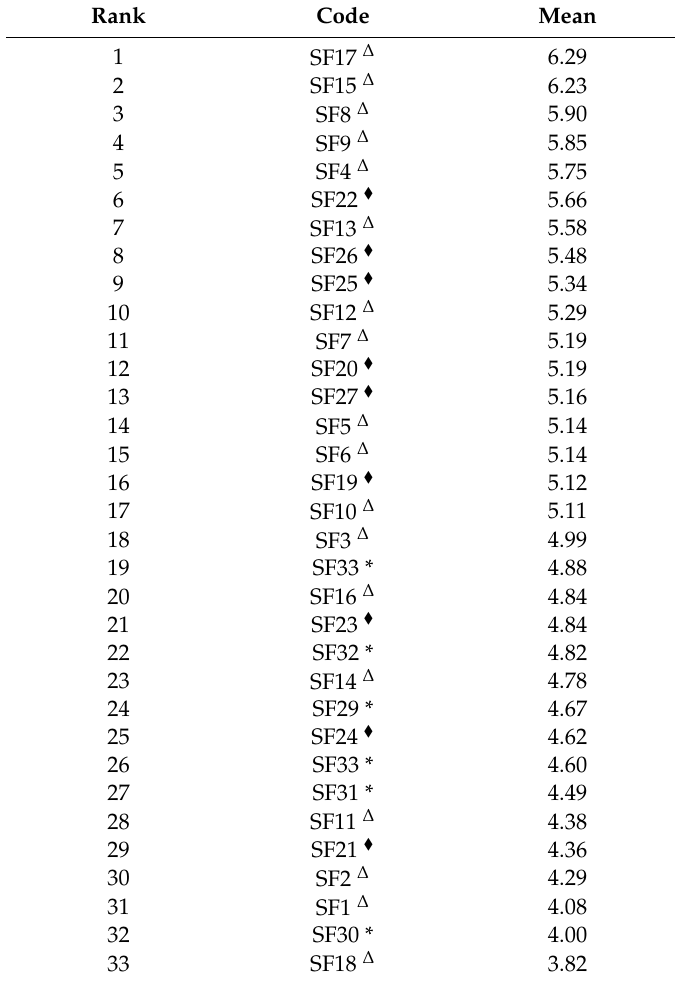
Table 3. Rank of factors a ff ecting contractors’ BNB